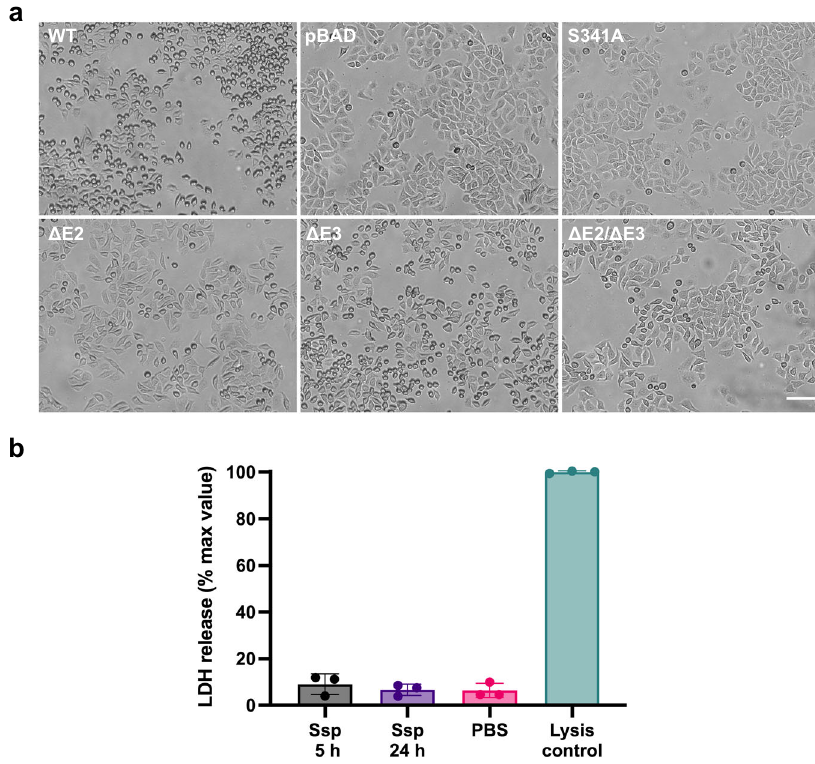
Fig. 4 | Effect of Ssp on HEp-2 cells. a HEp-2 cells were incubated with con- centrated culture supernatants of Ssp variants (25 μ g/mL) for 30min and imaged by DIC microscopy. Scale bar represents 100 μ m. Ssp variants include wildtype (WT), deletion of active site protrusions E2 and E3 ( Δ E2, Δ E3, Δ E2/ Δ E3), and site- directed mutant of the active site (S314A). pBAD denotes vector only control. Cell